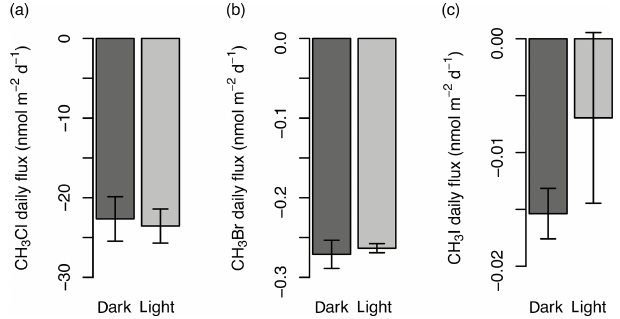
Figure 3. Comparison of the gas flux (nmolm − 2 d − 1 ) in un- darkened (light) and darkened (dark) chambers for CH 3 Cl (a) , CH 3 Br (b) , and CH 3 I (c) from preliminary experiments in 2016. Error bars show the standard